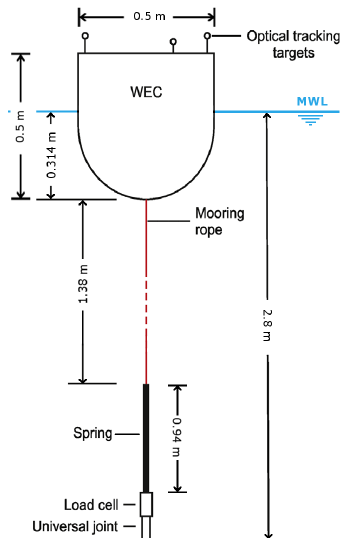
Figure 3. Extreme loading of marine energy devices due to waves, current, flotsam and mammal impacts (X-MED) model